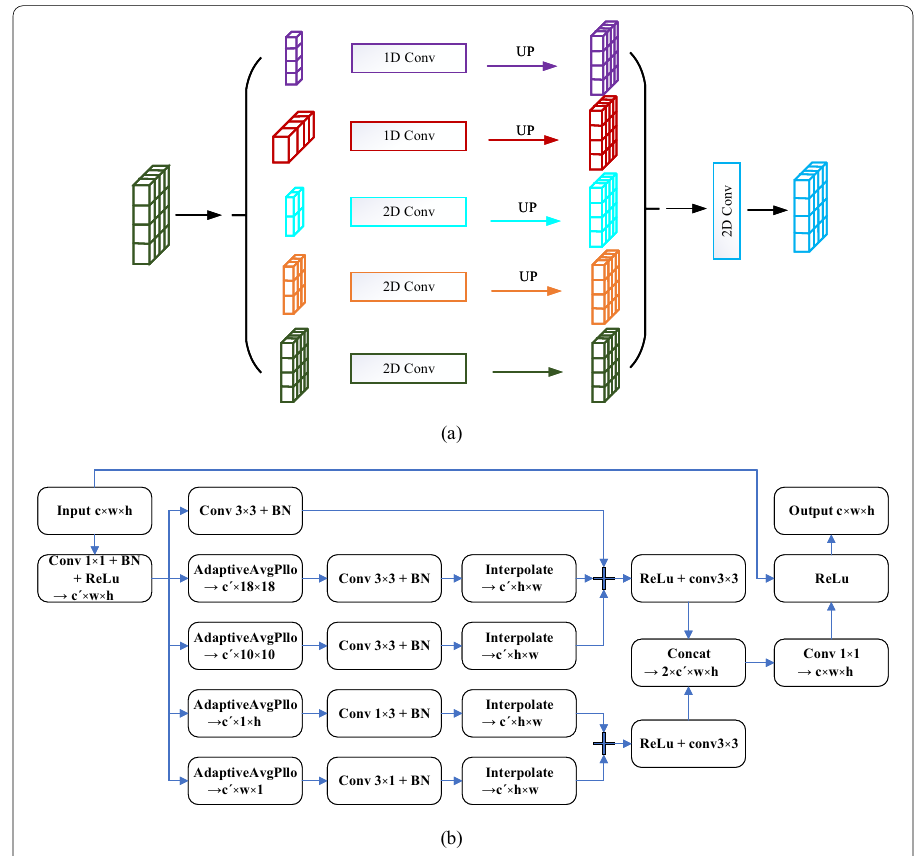
Fig. 3 The designed Mixed Pooling Module (MPM): a is the simplified MPM diagram; b is the detailed MPM